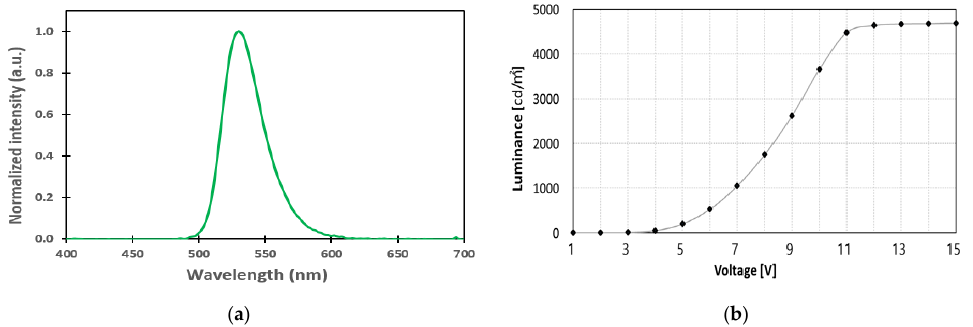
Figure 4. Measured electro-optical characteristics of the OLED cell: ( a ) electroluminescence spectrum and ( b ) luminance on voltage characteristic.